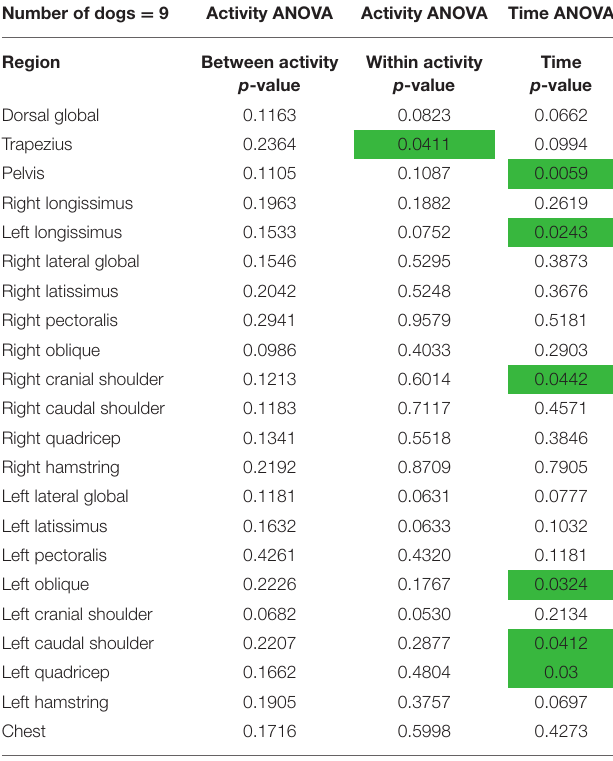
study was not designed to evaluate dogs with leash training vs.